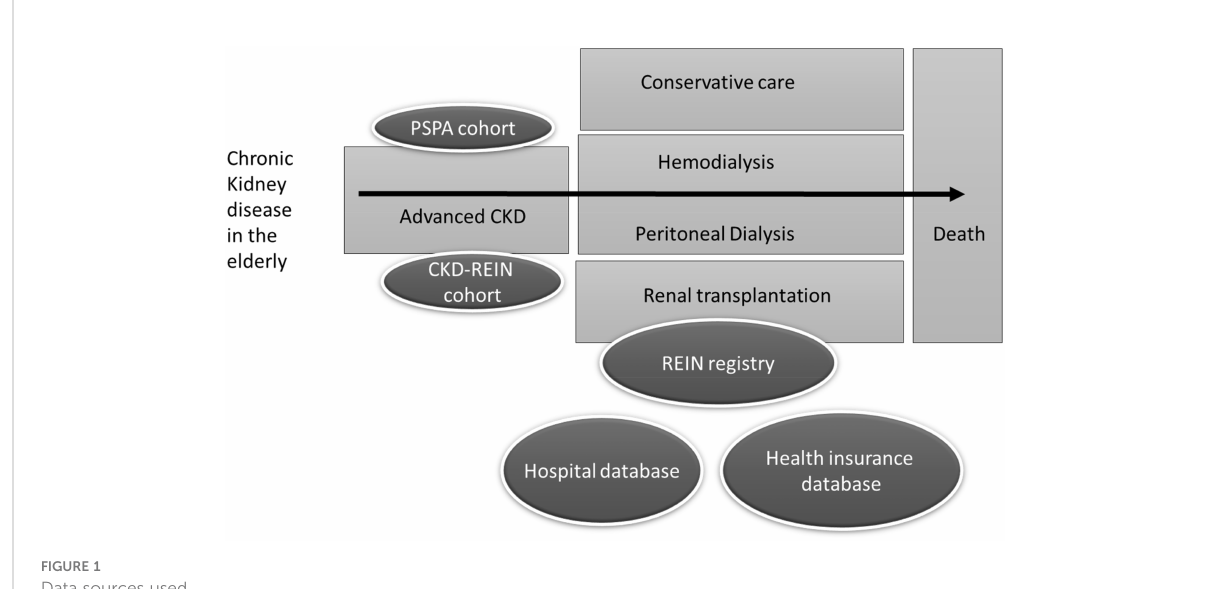
FIGURE 1 Data sources